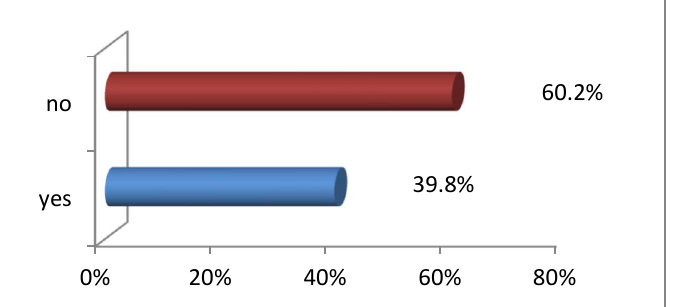
Figure 3. Respondents’ responses to whether there is adequate supervision for students by profes- sional nurses (N = 196).